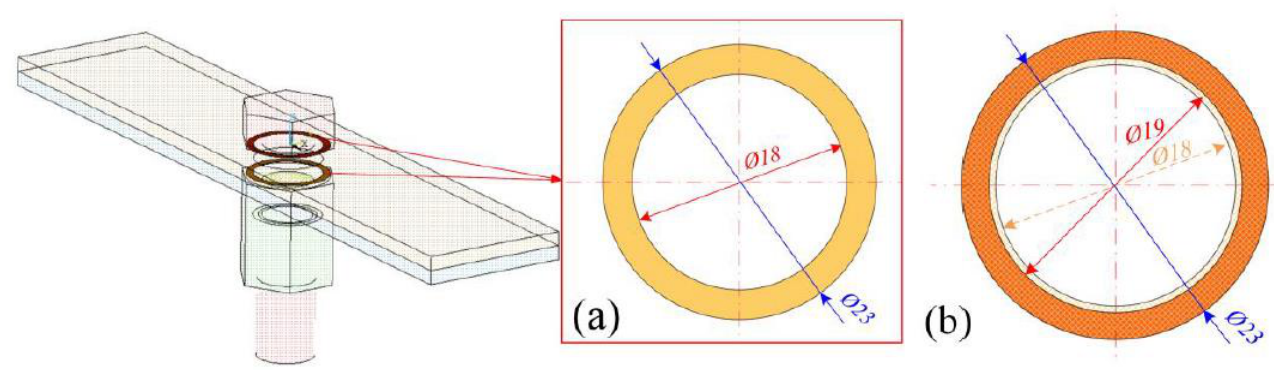
Figure 22. Contact interfaces between the bolt head/nut and beams, ( a ) larger interfaces (hole diameter 18 mm), ( b ) smaller interfaces (hole diameter 19 mm).